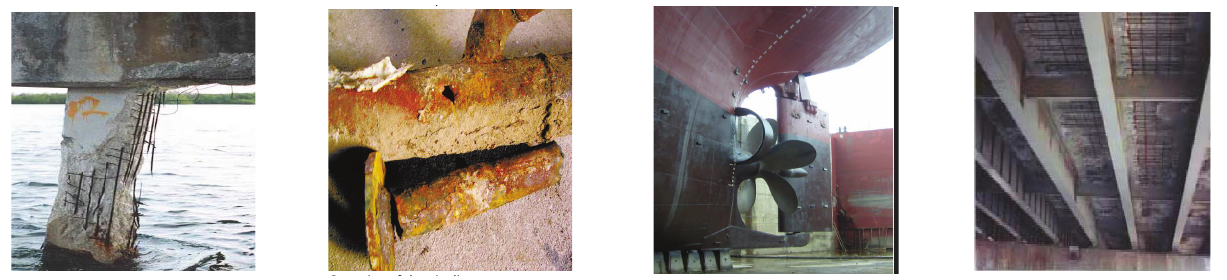
Figure 1. Some typical corrosion scenarios, respectively, in a steel-concrete structure, a pipeline, a cargo ship, and a marine platform (from left to